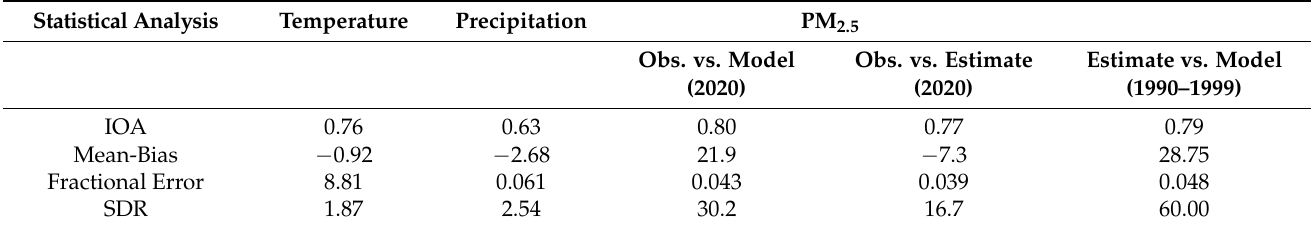
Table 1. The statistical comparisons between model, observation, and estimation in northern Thailand.